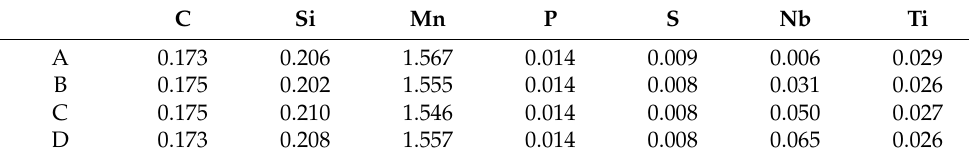
Table 1. Chemical composition of high-rise structural steel with different Nb contents